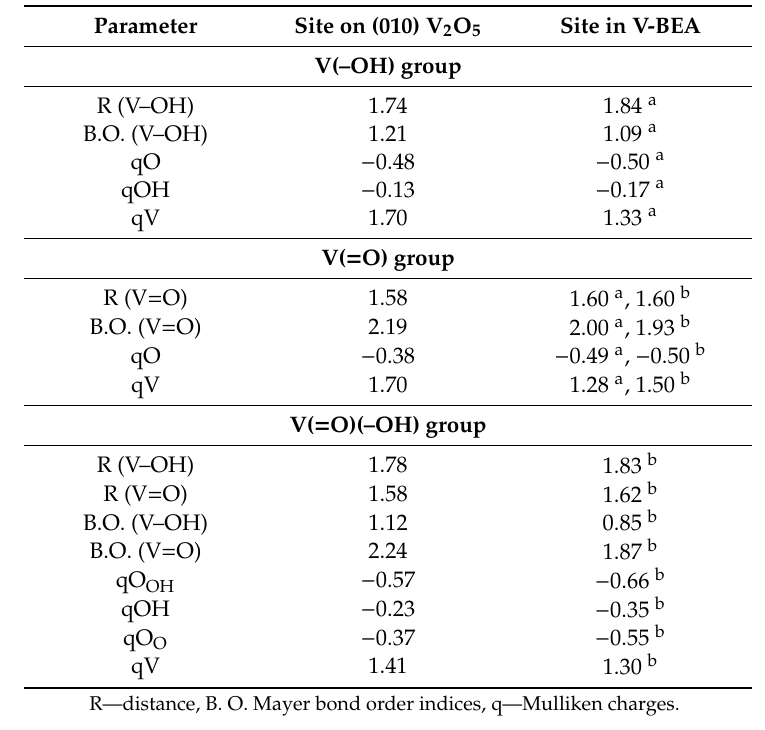
Table 5. Structural parameters of the investigated vanadium groups present on the (010) V 2 O 5 and introduced to most stable crystallographic positions in BEA zeolite ( a T2 site, b T3 site). O O denotes vanadyl oxygen, O OH denotes oxygen from hydroxyl. Parameter